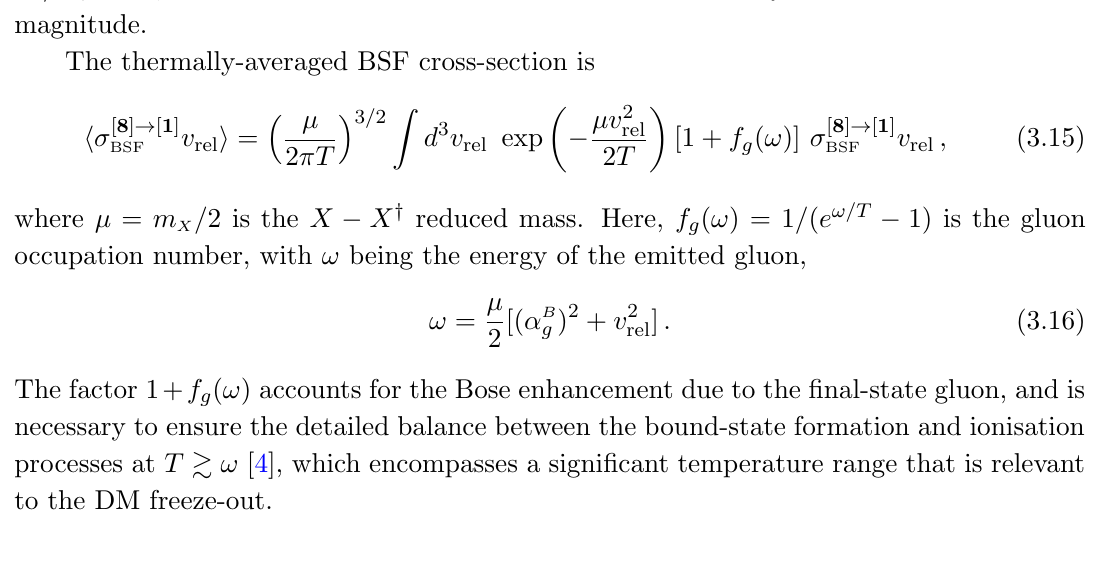
Figure 4. Left panel : the strong coupling (cid:11) B colour-singlet bound-state wavefunction. Right panel : the strong coupling at the gluon emission vertex during the formation of colour-singlet bound states, (cid:11) BSF the binding energy of the bound state plus the kinetic energy of the scattering state; we show (cid:11) BSF in the range 0 : 2 6 v rel 6 0 : 4 that is indicative of the relative velocities during DM